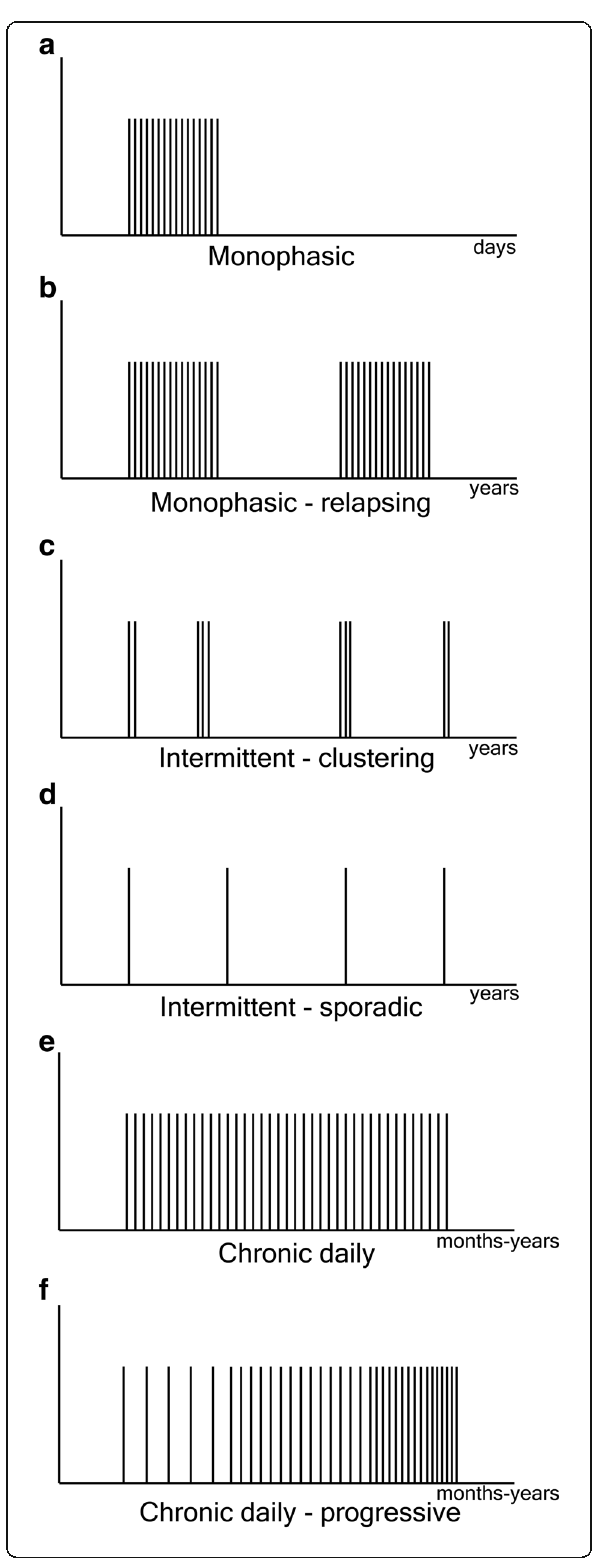
Fig. 3 Clinical patterns of primary stabbing headache. a - b Monophasic pattern ( n =28). In the monophasic group, a relapse was reported in 10 patients (35.7%). c - d Intermittent pattern ( n =17). Stabs occur in cluster ( c ) or sporadically ( d ). e - f Chronic daily PSH ( n =12). Six patients reported a progressive course ( f